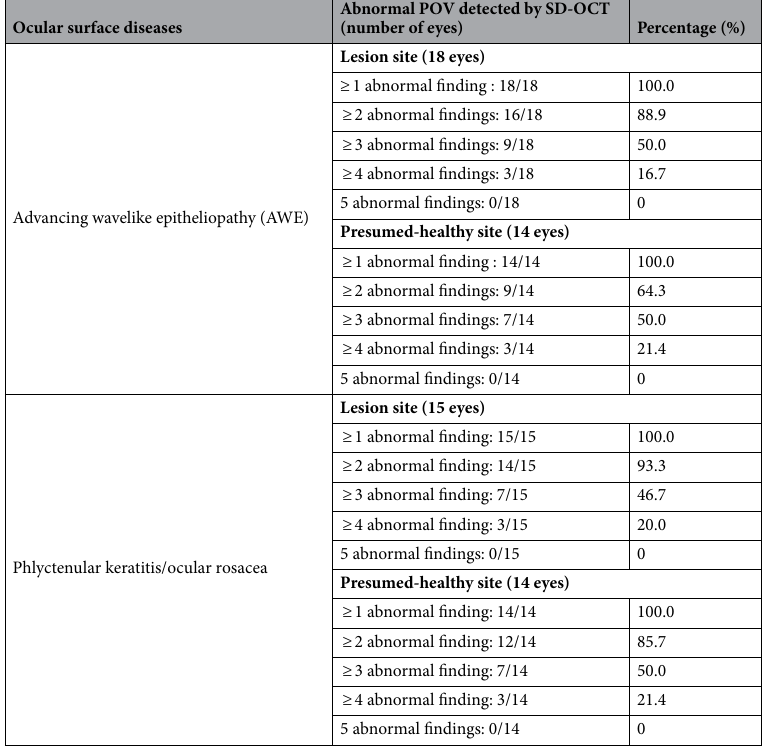
Table 3. Percentage of the abnormal POV detected through SD-OCT in the most severe lesion and presumed- healthy sites of the diseased eyes. In total, 4 of the 18 eyes in the AWE group and 1 of the 15 eyes in the phlyctenular keratitis/ocular rosacea group showed limbal involvement in all the four quadrants of the limbal area. Accordingly, there are presumed-healthy sites of the limbus in the 14 disease eyes in both the AWE group and the phlyctenular keratitis/ocular rosacea group. POV palisades of Vogt, SD-OCT spectral-domain optical coherence tomography.